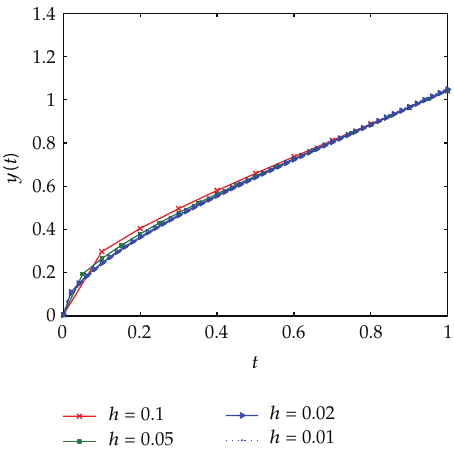
Figure 1: The numerical solutions of Example 4.1 with di ff erent step sizes.